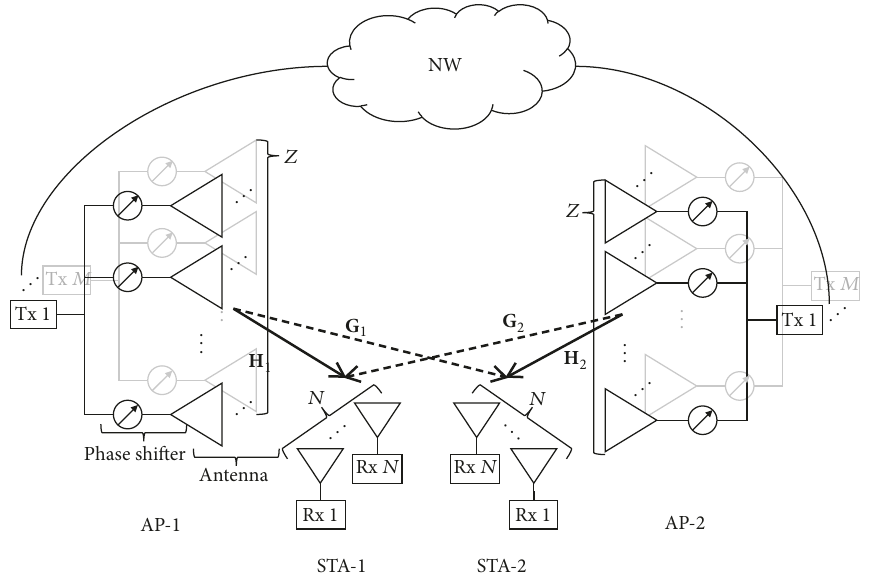
Figure 1: System